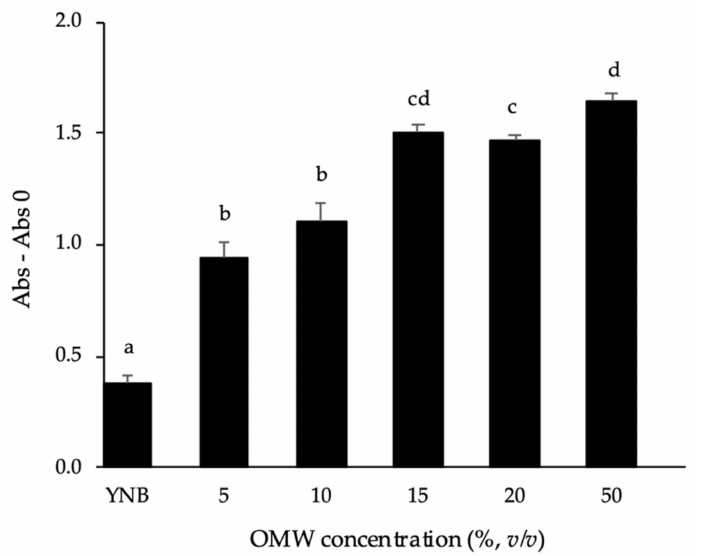
Figure 1. Candida tropicalis ATCC 750 growth in several OMW-1 concentrations evaluated by the difference in the optical density ( λ = 600 nm) at the end (48 h) and at the beginning (0 h) of the experiments. YNB medium was used as the control. The error bars represent the standard deviation of three independent replicates. Bars with the same letter do not present statistically significant differences ( p ≤